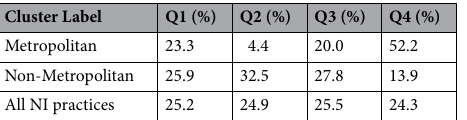
Table 4. Percentage of Practices in Deprived Areas (Q =